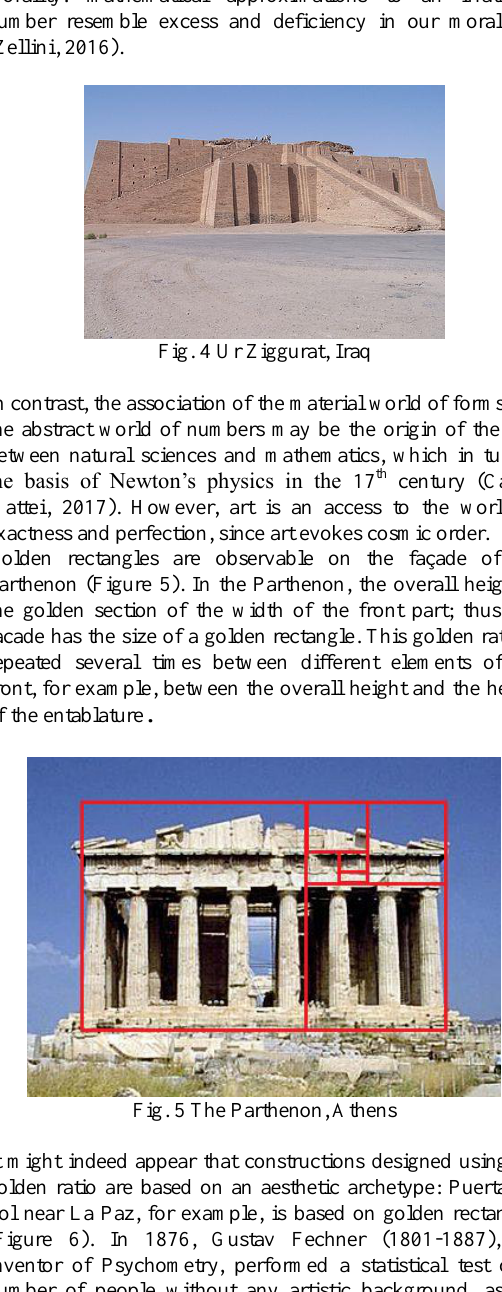
(Figure 9) of such is Sant’ Andrea Church in Mantua (Leon Battista